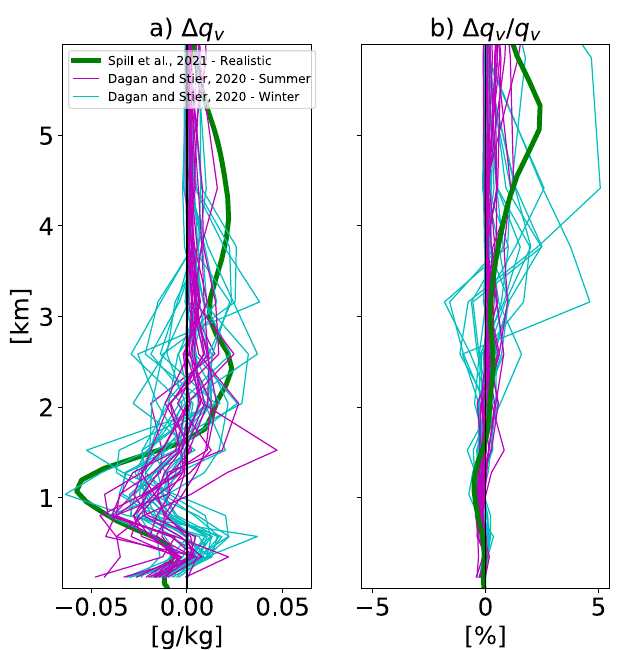
Fig. 4 Water vapor mixing ratio response to aerosol perturbation in realistic shallow-convective clouds simulations. Vertical pro fi les of the domain and time mean a change in water vapor mixing ratio — q v , and b relative change in q v due to an aerosol perturbation (normalized to an order-of-magnitude increase in aerosol concentration). Same as Fig. 3 but focused only on the realistic